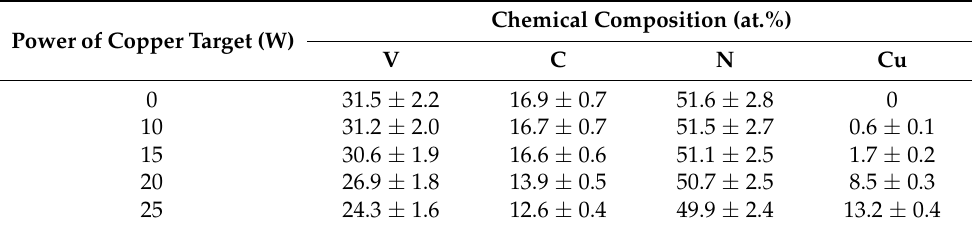
Table 2. The composition of VCN–Cu films.